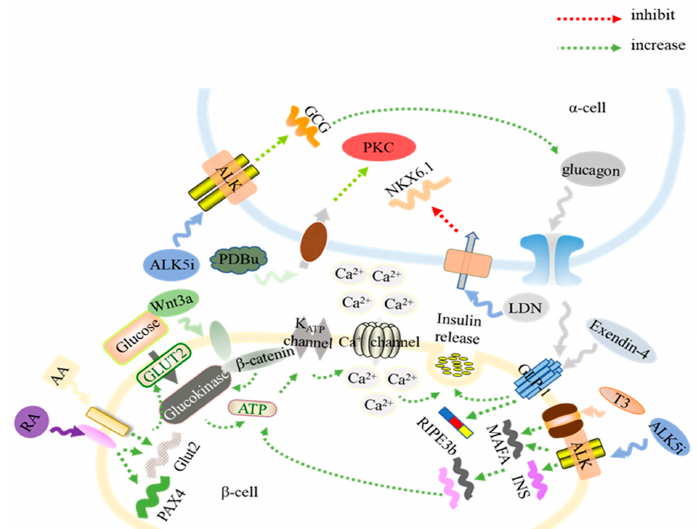
Figure 1. The mechanisms of signaling molecules that enhance the generation of glucose-responsive insulin (INS)-secreting β -cells and functional α -cells. Treatment with retinoic acid (RA) and activin A (AA) increases the expression of Glut2, which transports glucose into β -cells. After a series of reactions, there is Ca 2 + flux into β -cells, inducing insulin secretion. Wnt3a enhances the process of glucose intake and insulin secretion. Treatment with activin receptor-like kinase 5 (ALK5) inhibitor (ALK5i) and triiodothyronine (T3) enhances the expression of MafA. The ALK5i also promotes the transcription of glucagon (GCG) in α -cells. The paracrine of glucagon and exendin-4 stimulates the formation of RIPE3b, which positively impacts on insulin secretion. Treating pre- α cells with LDN193189 (LDN) decreases the expression of NKX6.1, resulting in an induction of di ff erentiation into mono-hormonal α -cells. The protein kinase C (PKC) activator, phorbol 12,13-dibutyrate (PDBu), also augments the generation of pre- α cells into α